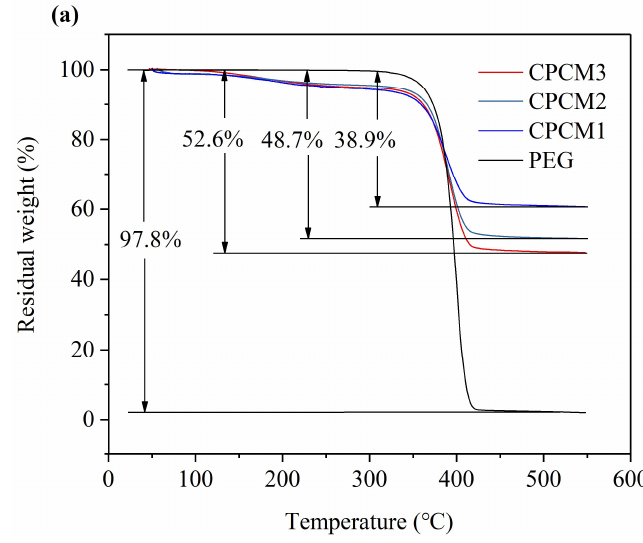
Table 1. TGA test results of PEG and